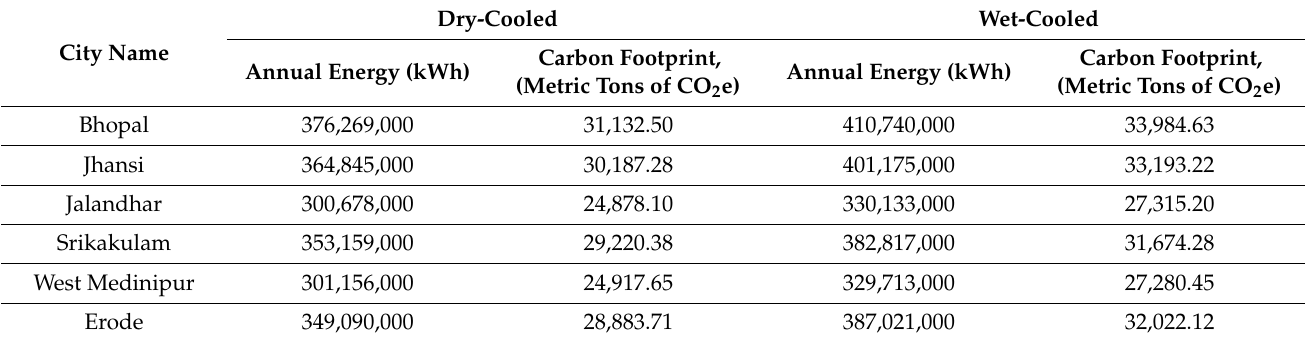
Table 4. Avoided emissions due to the use of the CSP